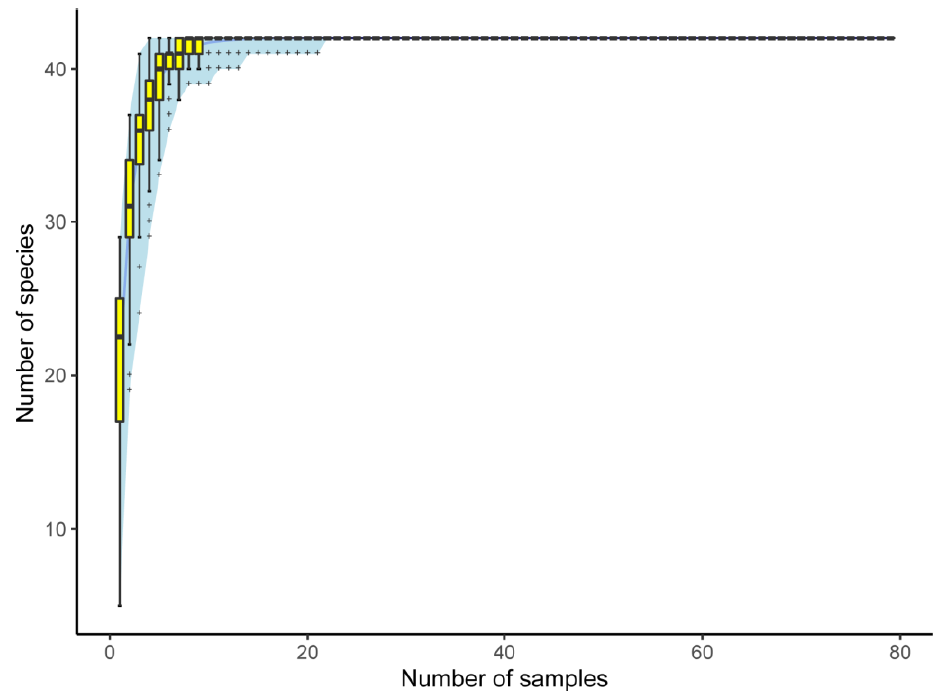
Figure 3. Sample-based species accumulation curve for the overall data set (Center bars are median values, color boxes are interquartile ranges (IQR), whisker lengths are ± 1.5 * IQR, and cross marks are outliers; shaded area is a min — max area).